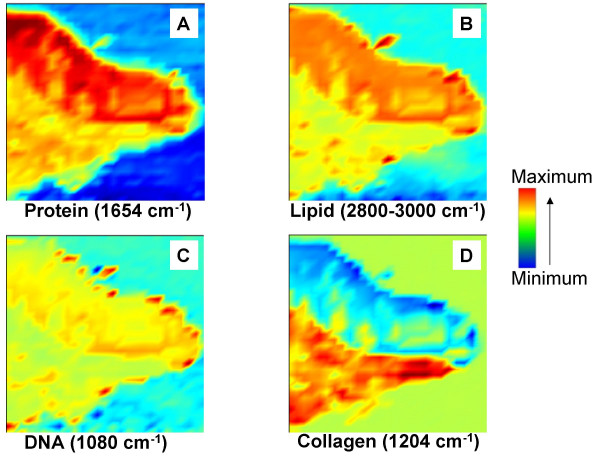
IR chemical mappings in periodontal tissue. Four major molecular distributions (total protein; lipid; DNA; collagen) in periodontal tissue (A-D) were generated based on the corresponding IR molecular signals. Higher concentrations of the major cellular components were observed in the periodontal epithelium (A-C) whereas higher amounts of collagen exist in the connective tissue (D), as expected.